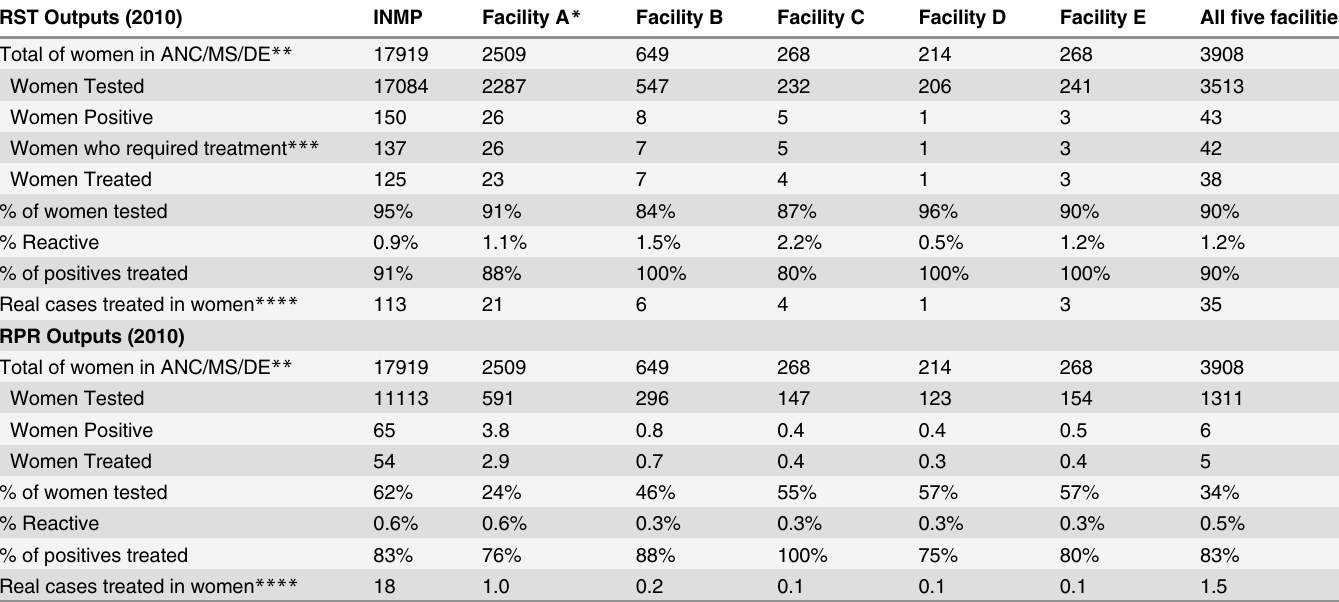
Table 1. Screening and treatment